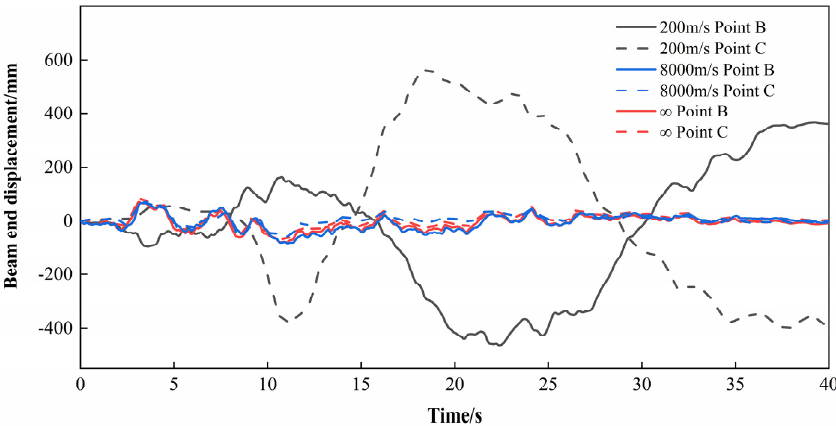
Figure 20. Time course of main bridge end displacement at different visual wave speeds.